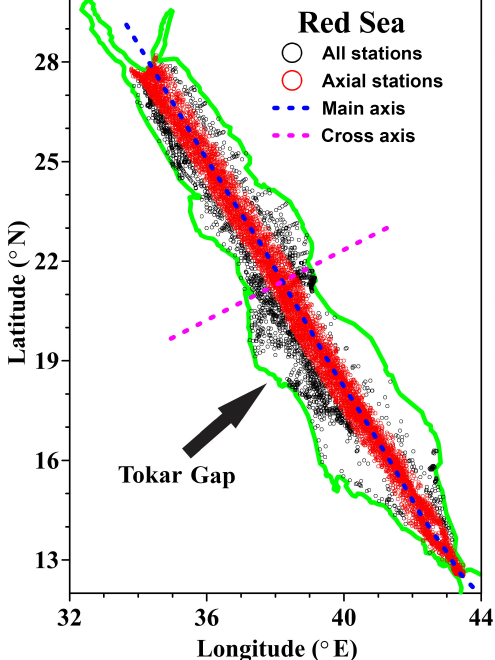
Figure 1. The locations of temperature profiles in the Red Sea. Black circles denote all available profiles, while red circles denote the profiles close to the main axis that are used for climatology cal- culation. The blue (magenta) dashed line indicates the main axis (cross axis) of the Red